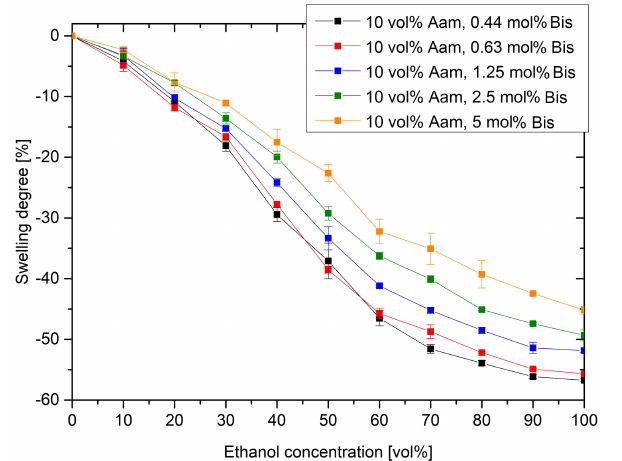
Figure 8. Influence of the bisacrylamide concentration on the swelling degree of the hydrogels.